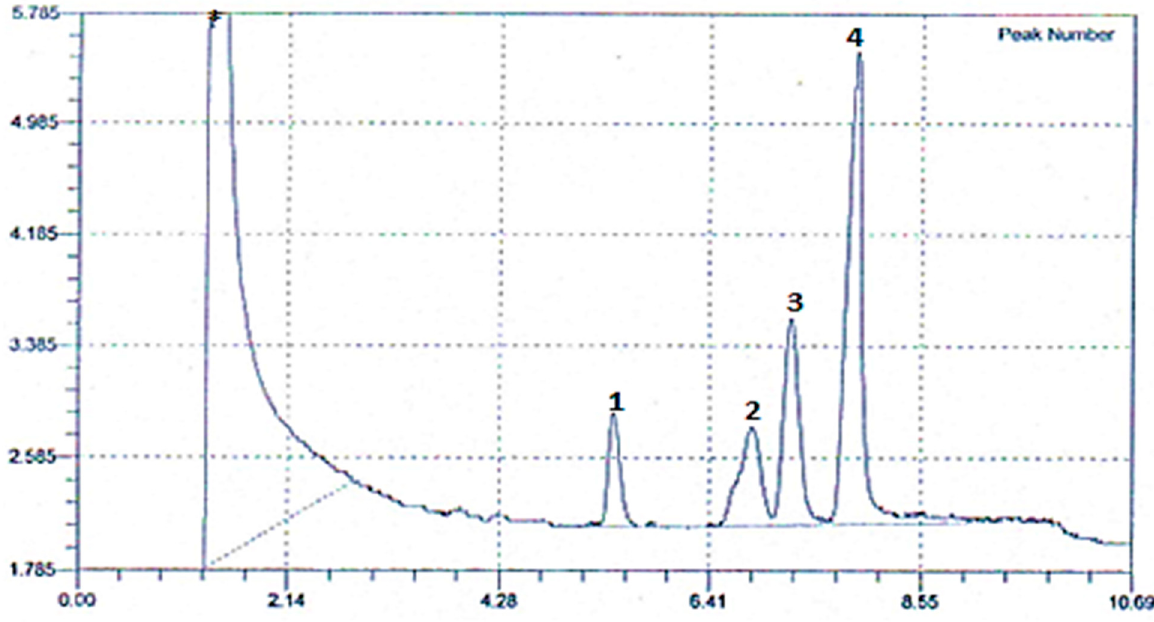
Figure 15. Barthenosteriode at 5 mL/L GLC. (* is the solvent, 1 is the palmitic acid, 2 is oleic acid, 3 is a Linoleic acid and 4 is the α - α linolenic acid) of chia ( Salvia hispanica L.) fixed oil content as impacted by various bio-stimulating materials.